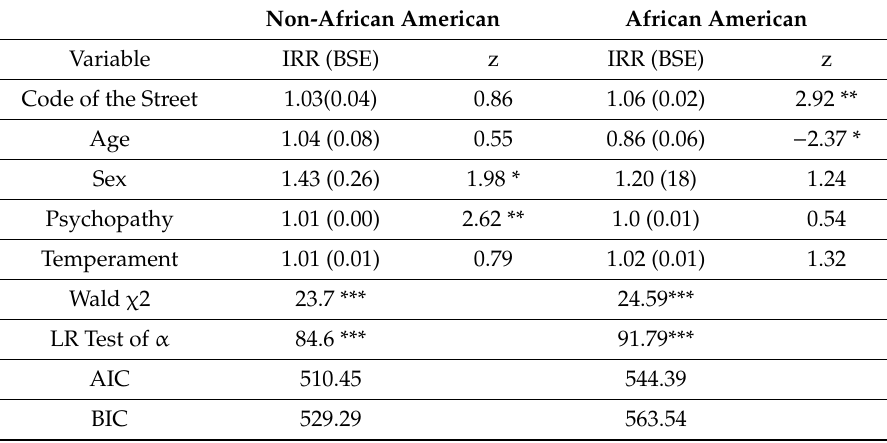
Table 4. Negative binomial regression models for self-reported arrests by African American